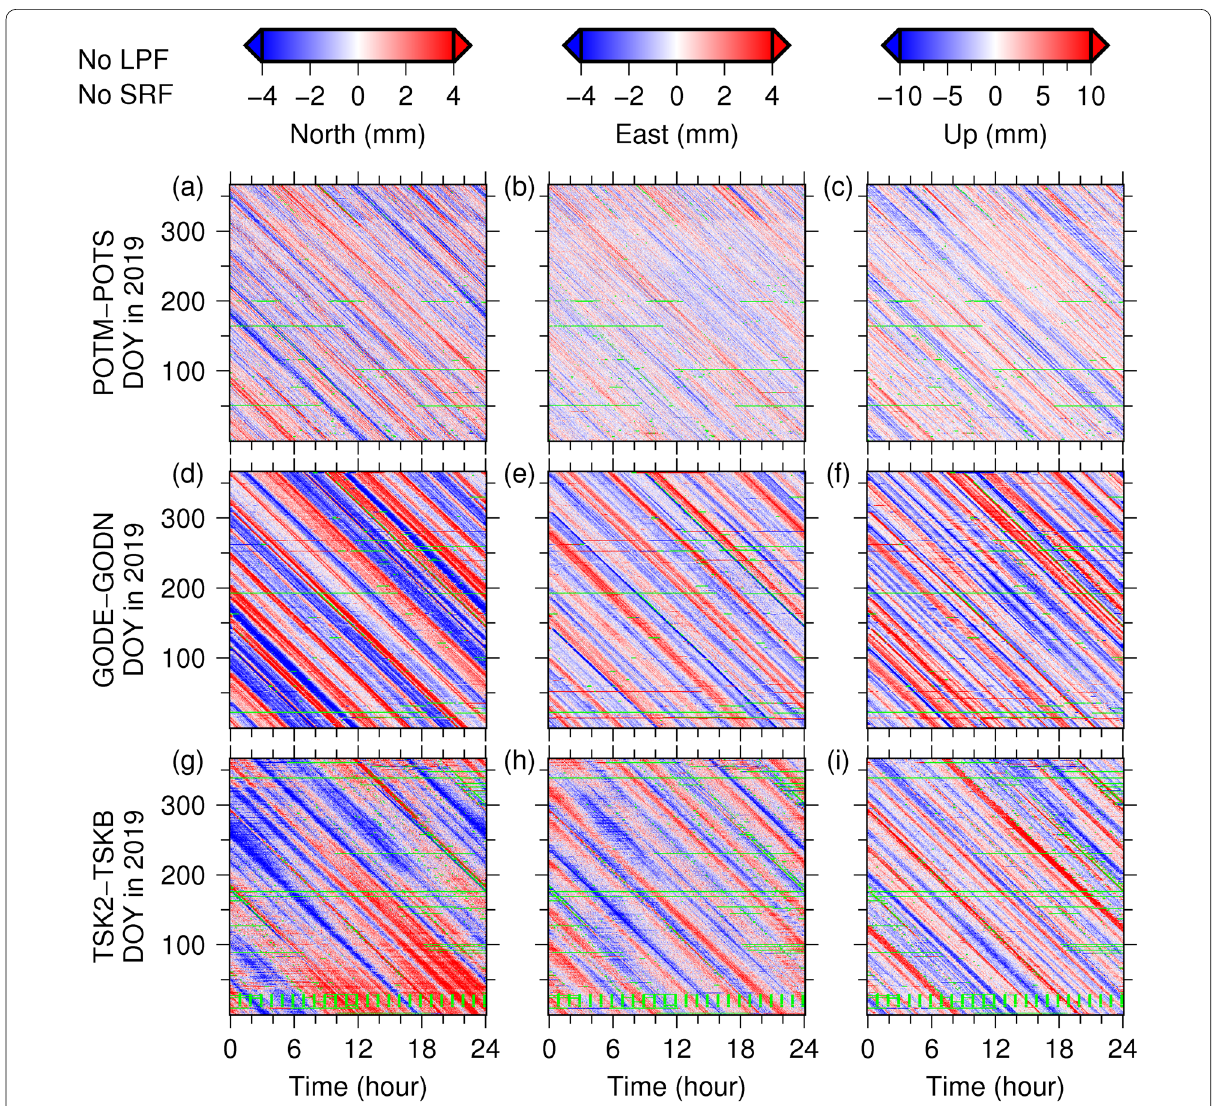
Fig. 2 Coordinate fluctuation of three baselines as labeled in each day of year (DOY). Left ( a , d , and g ), center ( b , e , and h ), and right ( c , f , and i ) columns indicate north, east, and up components, respectively. Neither low-pass filtering (LPF) nor sidereal filtering (SRF) is applied. Green color indicates epochs filled by interpolation of neighboring epochs during the data cleaning